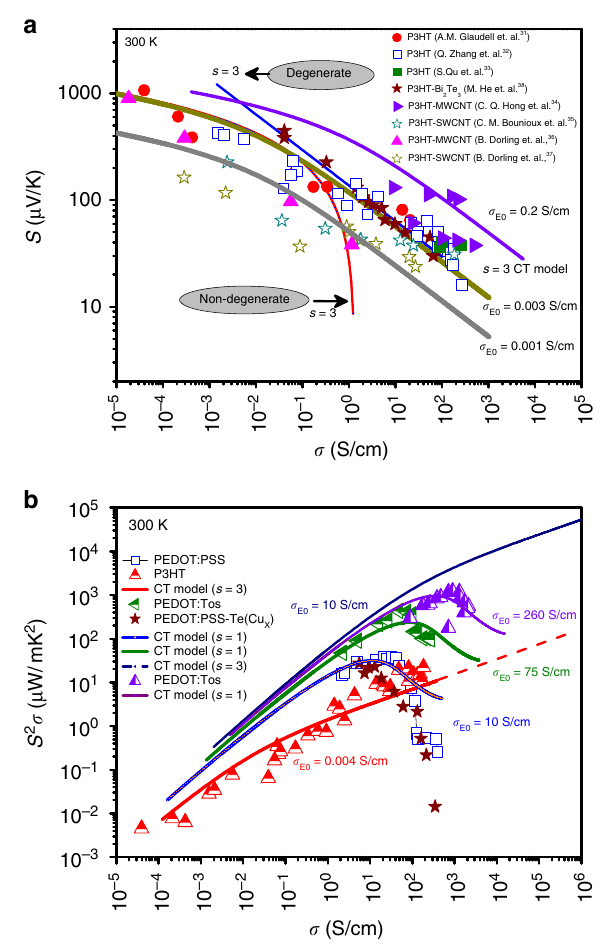
Fig. 5 Kang-Snyder model applied to various P3HT-inorganic composites. a The electrical conductivity vs Seebeck coef fi cient data of F 4 TCNQ doped P3HT (closed circles) 31 , Fe((CF 3 SO 2 ) 2 N) 3 doped P3HT (open squares) 32 , highly aligned P3HT with trichlorobenzene (closed squares) 33 , P3HT: MWCNT (closed triangles) 35,36 , P3HT:SWCNT (open star) 37,38 and P3HT: Bi 2 Te 3 (closed stars) 34 hybrid systems. It is seen that experimental data lies on s = 3 curve, again consistently identical for the hybrid and the pure polymeric systems. b Comparison of power factor of PEDOT (s = 1) and P3HT (s = 3) based hybrids. Targeting higher σ 10 S = cm in a s = 3 E 0 (cid:3)